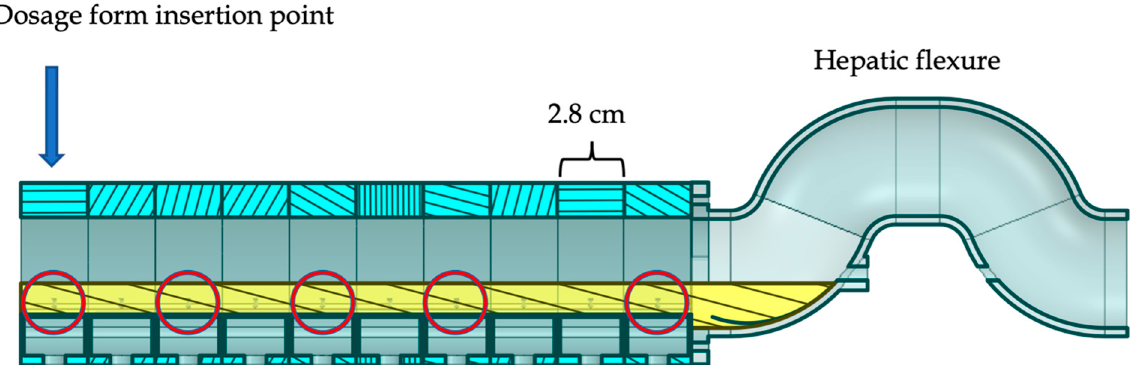
Figure 1. Cross section of the DCM partially filled with 100 mL fluid. Circled are the sample ports (SP) SP1, SP3, SP5, SP7 and SP10 from left to right. The DCM is comprised of 10 identical, modular segments of length 2.8 cm. A dosage form is introduced at segment (S) S1. Adjacent to the final segment, S10 at the opposite end of the tube is adjacent to the mimic hepatic flexure.